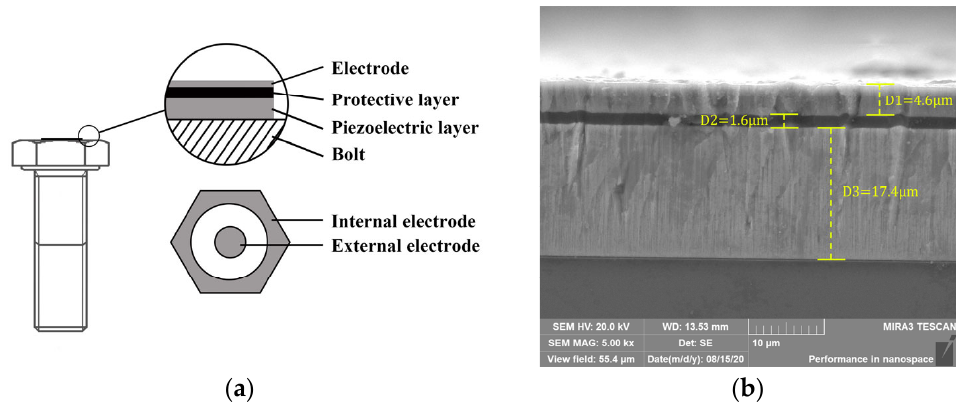
Figure 2. ( a ) Sensor structure diagram. ( b ) Film sensor cross ‐ section.